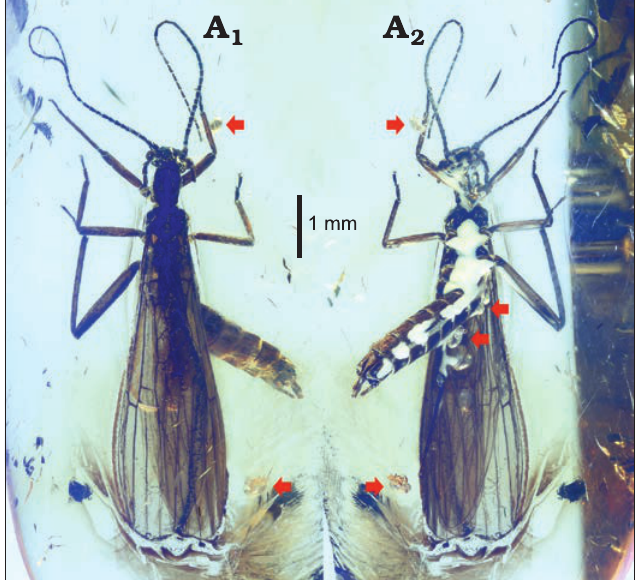
Fig. 1. Needle stonefly Baltileuctra dewalti Chen sp. nov. (holotype, ICJUST CZT-PLE-BA8) from Eocene Baltic Amber from unknown locality in Lithu- ania. Photomicrographs of male adult, habitus, in dorsal (A views. Sites of parasitic mites indicated by red arrowheads.